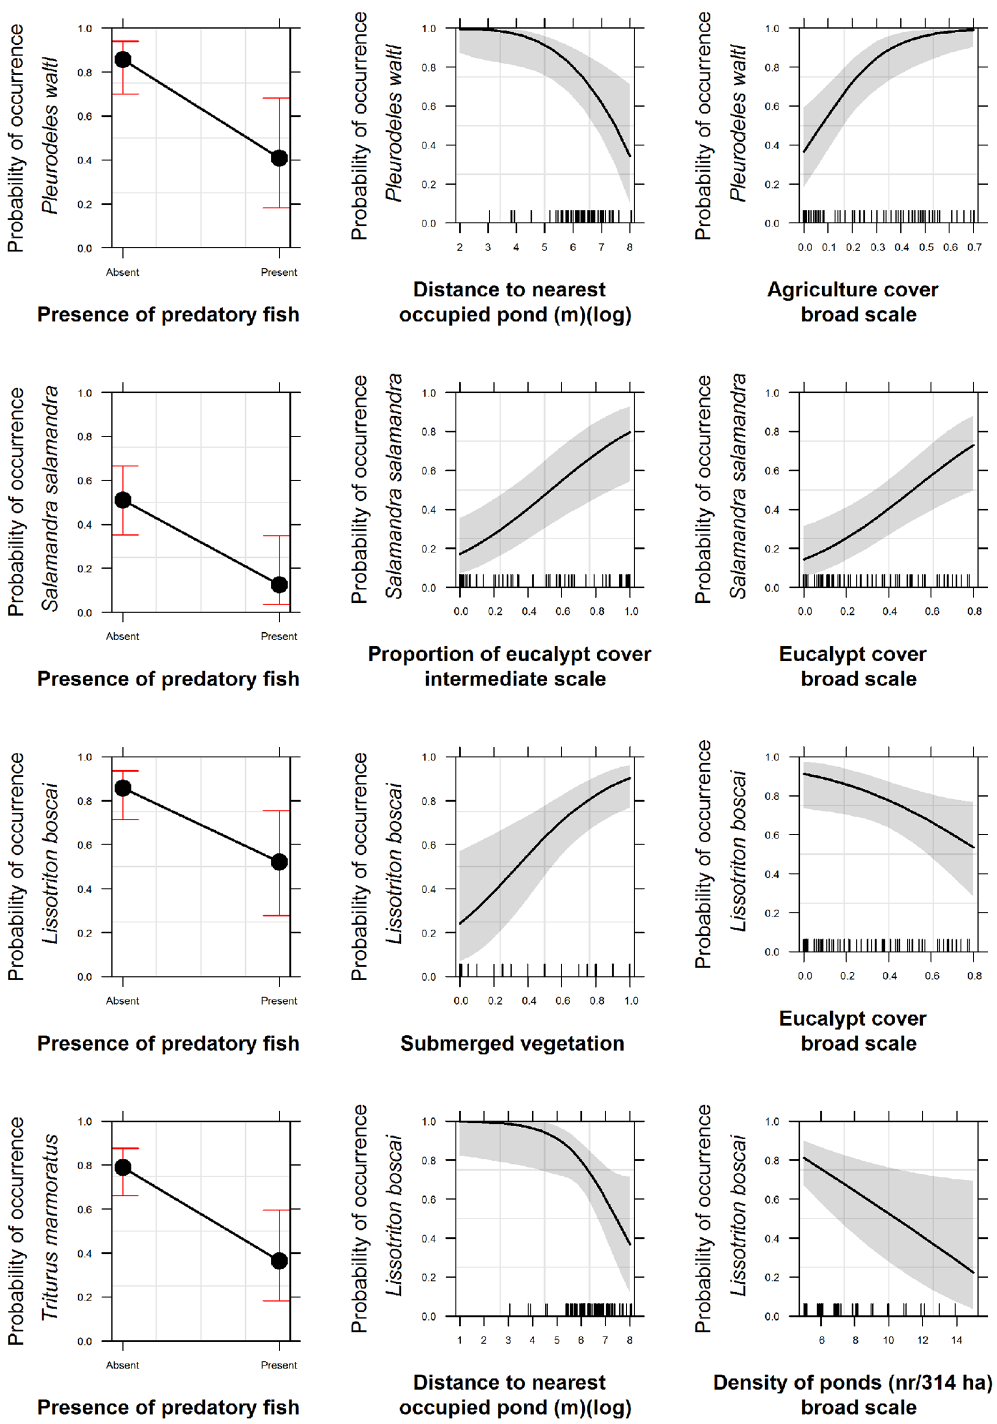
Fig 3. Fitted values predicted by the top ranked model for the Caudata for each of the response variables with strong effect according to the odds ratio results. The dashed line are the confidence intervals at 95%.